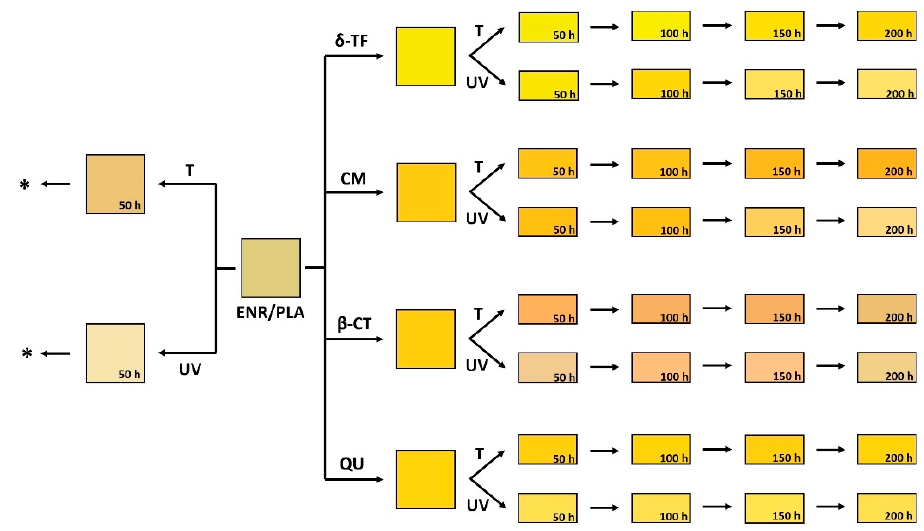
Figure 6. Color change representation for the prepared ENR/PLA blends before and after the accelerated thermo-oxidative (T), as well as UV-initiated (UV) aging processes. *—sample destroyed significantly.